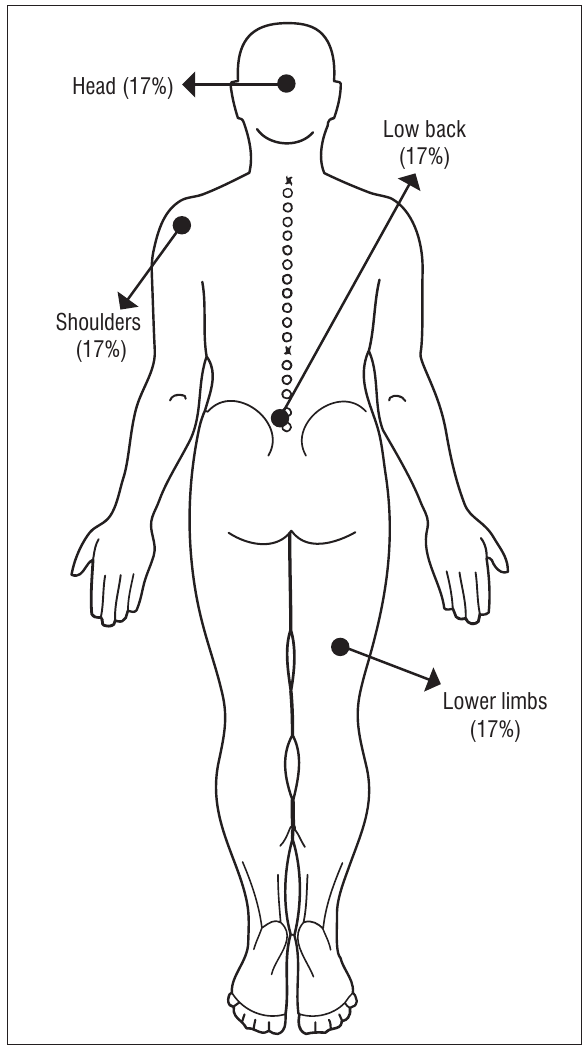
Figure 1 - Frequencies of musculoskeletal symptoms for the past 12 months and the previous week Source: Research